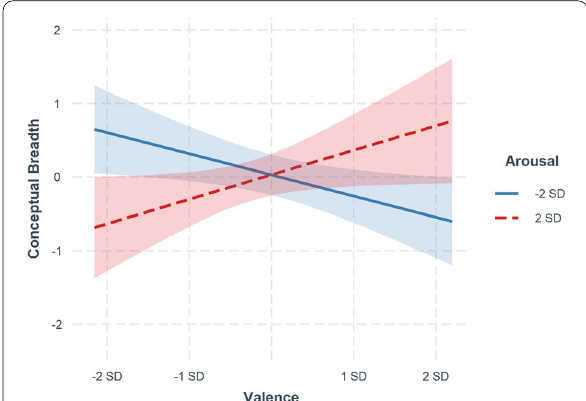
Fig. 3 Simple slopes depicting the relationship between conceptual breadth and valence scores separately for those low or high in arousal. Note that participants were generally positive in valence overall, and as such 1 SD for valence represents neutral valence as − opposed to negative valence. Arousal showed a full range of scores from very deactivated to very activated. Shaded areas represent the 95% confidence intervals for each